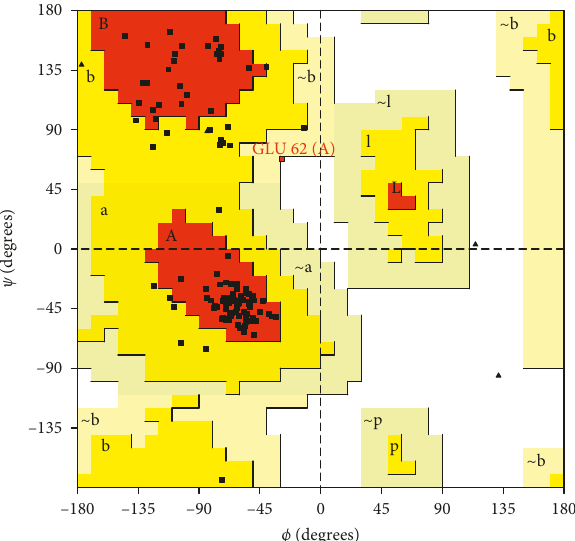
Figure 6: Steric validation, Ramachandran plot, of the optimized OBP model hierarchical virtual screening